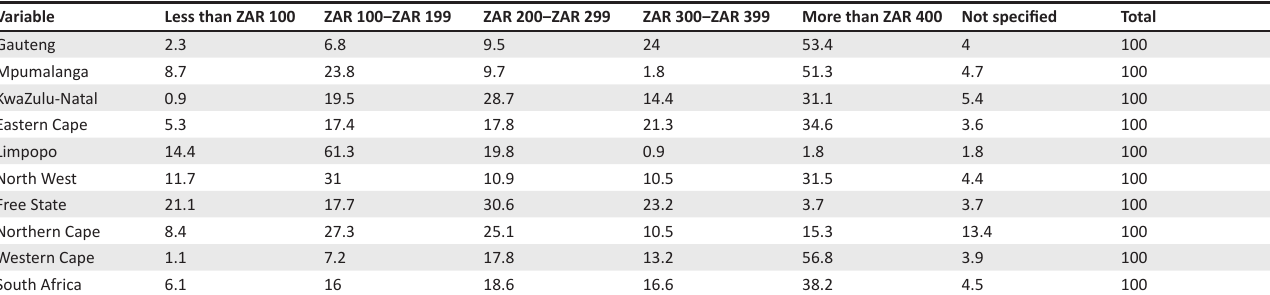
TABLE 5: Distribution of income earned in a bad week by day labourers per province, 2007 (percentages). Variable Eastern Cape